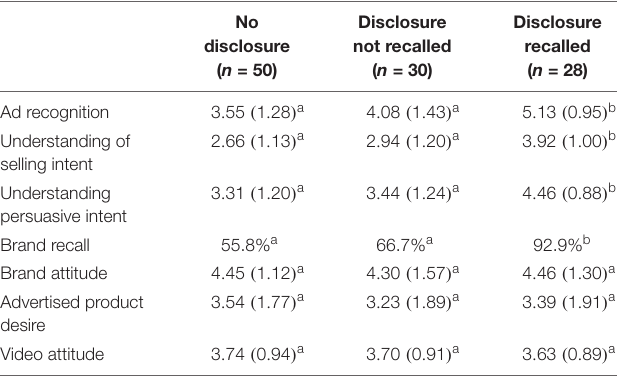
TABLE 1 | Effect of disclosure (vs. no disclosure) on advertising literacy and brand, product, and video